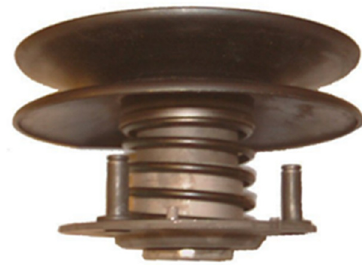
Figure 5. The driven